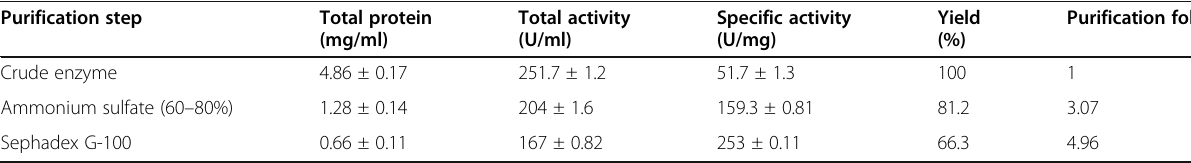
Table 3 Purification scheme for β -galactosidase from E. coli M-KH-UV-Tra44 Purification